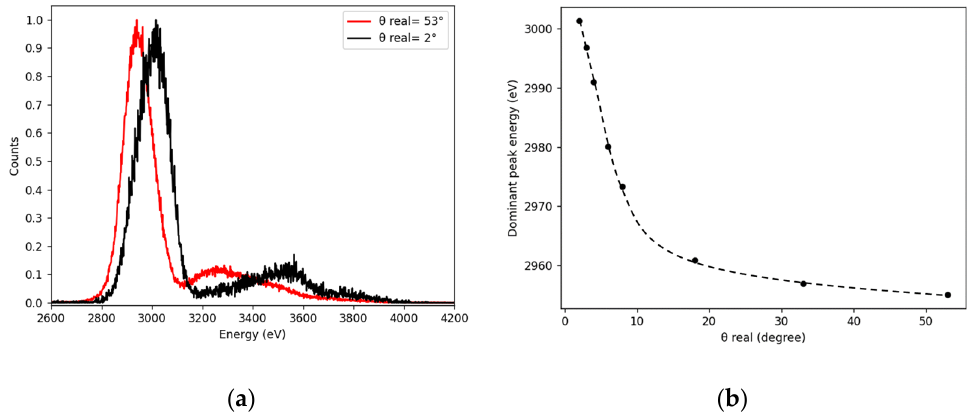
Figure 4. ( a ) X-ray spectra of Ar 17+ at 170 keV hitting a Si sample at real angles of 53 ◦ and 2 ◦ ; ( b ) K α Figure 4. ( a ) X ‐ ray spectra of Ar 17+ at 170 keV hitting a Si sample at real angles of 53° and 2°; ( b ) K α barycenter shift with respect to the barycenter shift with respect to the angle.